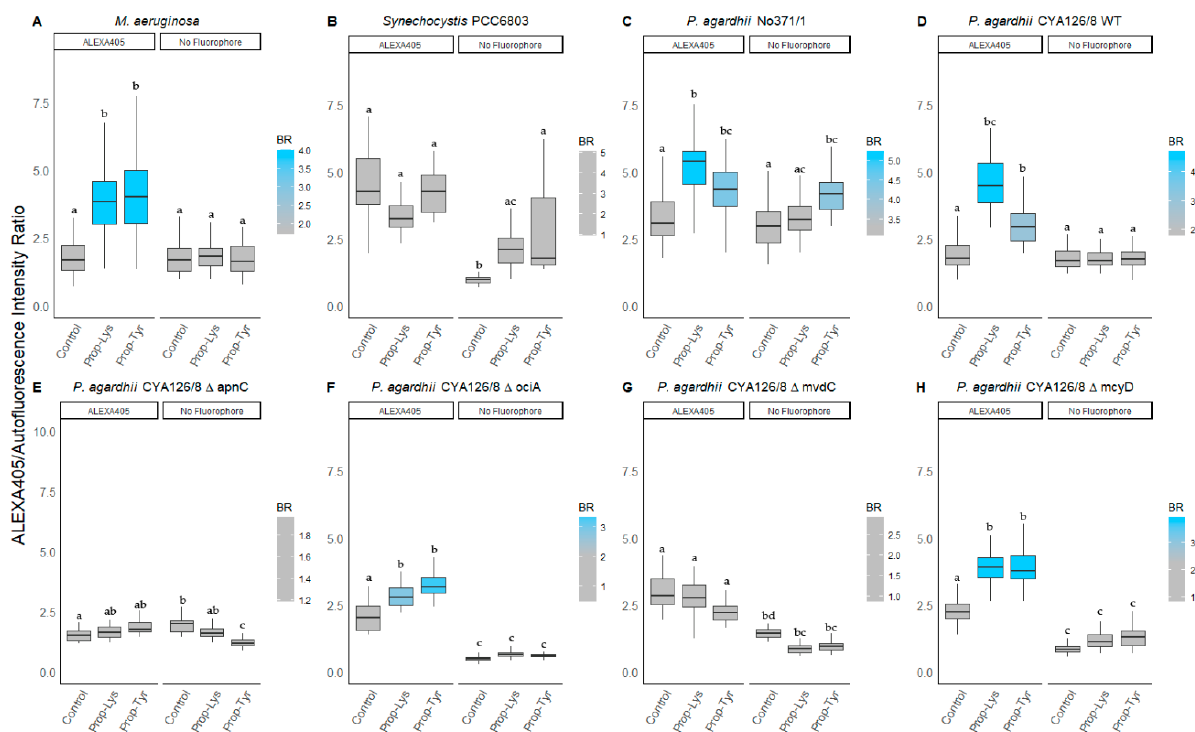
Figure 4. The ratio of blue fluorescence intensity (ALEXA405) to red intensity (AF) for individual cells or filaments from ( A ) M. aeruginosa , ( B ) Synechocystis PCC6803, and ( C ) P. agardhii strain No371/1, ( D ) CYA126/8 WT, and ( E – H ) CYA126/8 gene knock out mutants: ( E ) ∆ apnC (inactivated AP synthesis), ( F ) ∆ ociA (inactivated cyanopeptolin synthesis), ( G ) ∆ mvdC (inactivated microviridin synthesis), and ( H ) ∆ mcyD (inactivated MC synthesis) using non-natural amino acids (Phe-Az, Prop-Lys, and Prop-Tyr). Controls were grown without amino acid addition but used for the chemical reaction under identical conditions. No Fluorophore indicates filaments or cells grown with amino acid addition but no subsequent labeling by click-chemical reaction. The gradient in coloring was defined for each strain separately using the average intensity from the control cultures. Superscripts indicate statistically significant different subgroups after overall difference was found ( p <